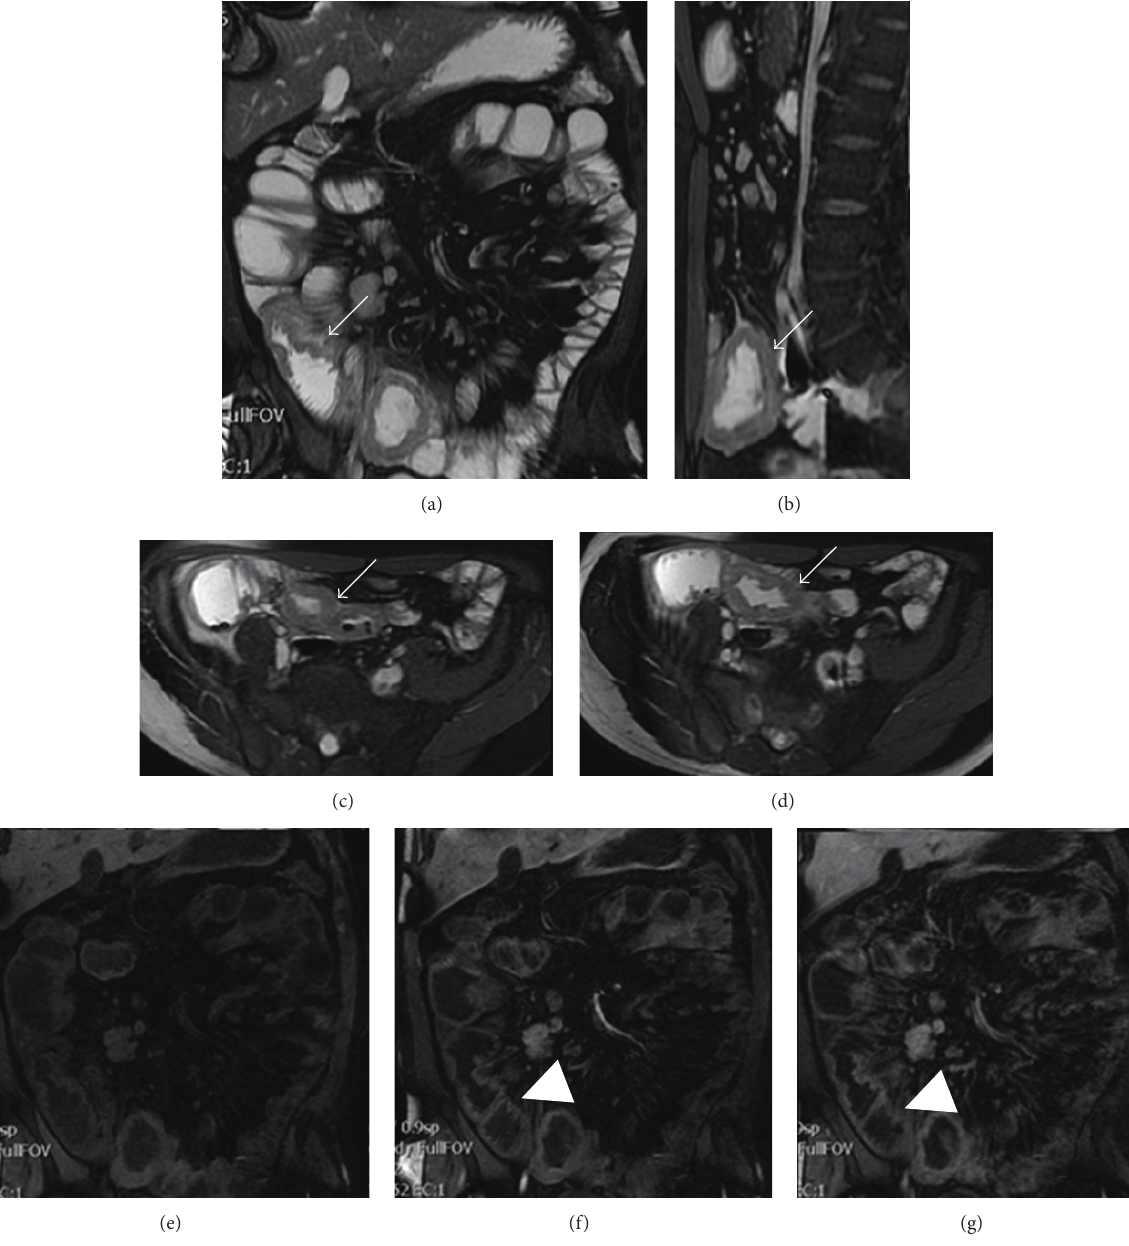
Figure 3: Abdominal MR enterography in the same patient of Figure 2. MR enterography shows the presence of a circumferential thickening of an ileal bowel loop (arrows) in the coronal (a), sagittal (b), and axial ((c) and (d)) planes, before contrast medium injection. Compared to the coronal precontrastographic phase (e), this thickening shows mild contrast enhancement in the arterial (f) and portal venous phase (g)